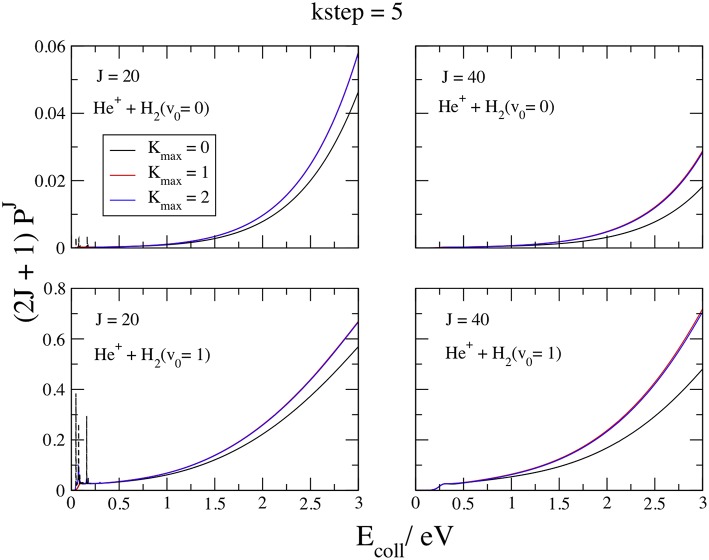
v0 = 0, 1; J = 20, 40; kstep = 5. Convergence of the opacities (2J+1)Pv0J with respect to Kmax.